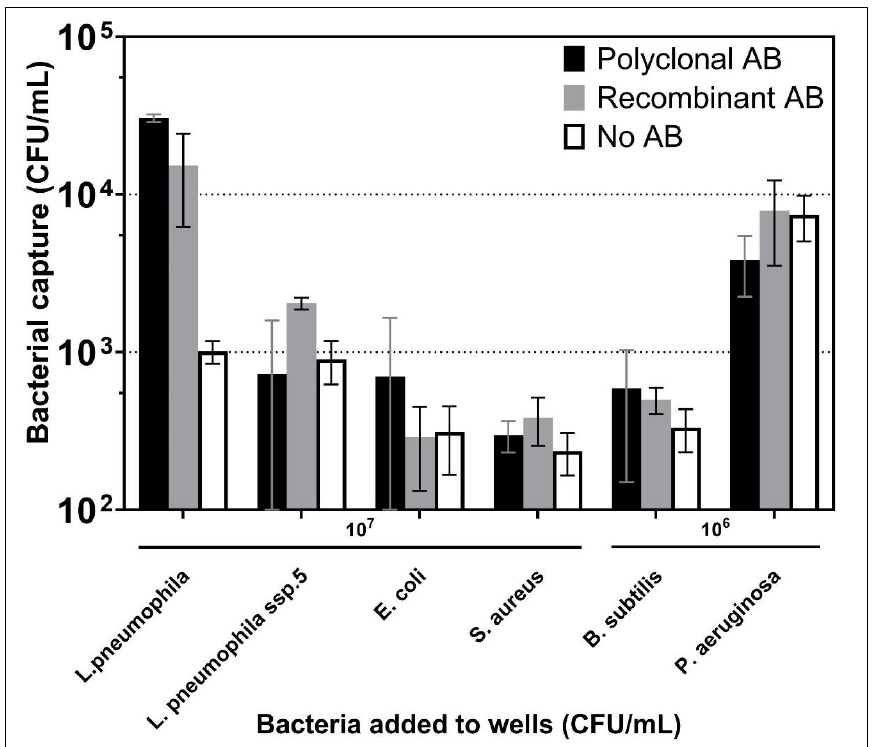
Figure 4. Capture of different bacteria in wells coated with pAb or recAb. The concentration of bacteria added to the wells was 10 7 CFU/mL for L. pneumophila ; E. coli ; S. aureus ; L. pneumophila ssp5 and 10 6 CFU/mL for B. subtilis ; P aeruginosa ( n = 3). The bacterial capture levels were quantified by qPCR using 16S rDNA primers and probe. Error bars are shown to indicate standard deviation. This indicated that Ab wells did not capture non-target bacteria significantly. How- ever, L. pneumophila ssp5 did show significant capture with recAb (2.0 × 10 3 CFU/mL), al- beit nearly 10 times less than the capture of L. pneumophila ssp1 (1.5 × 10 4 CFU/mL).